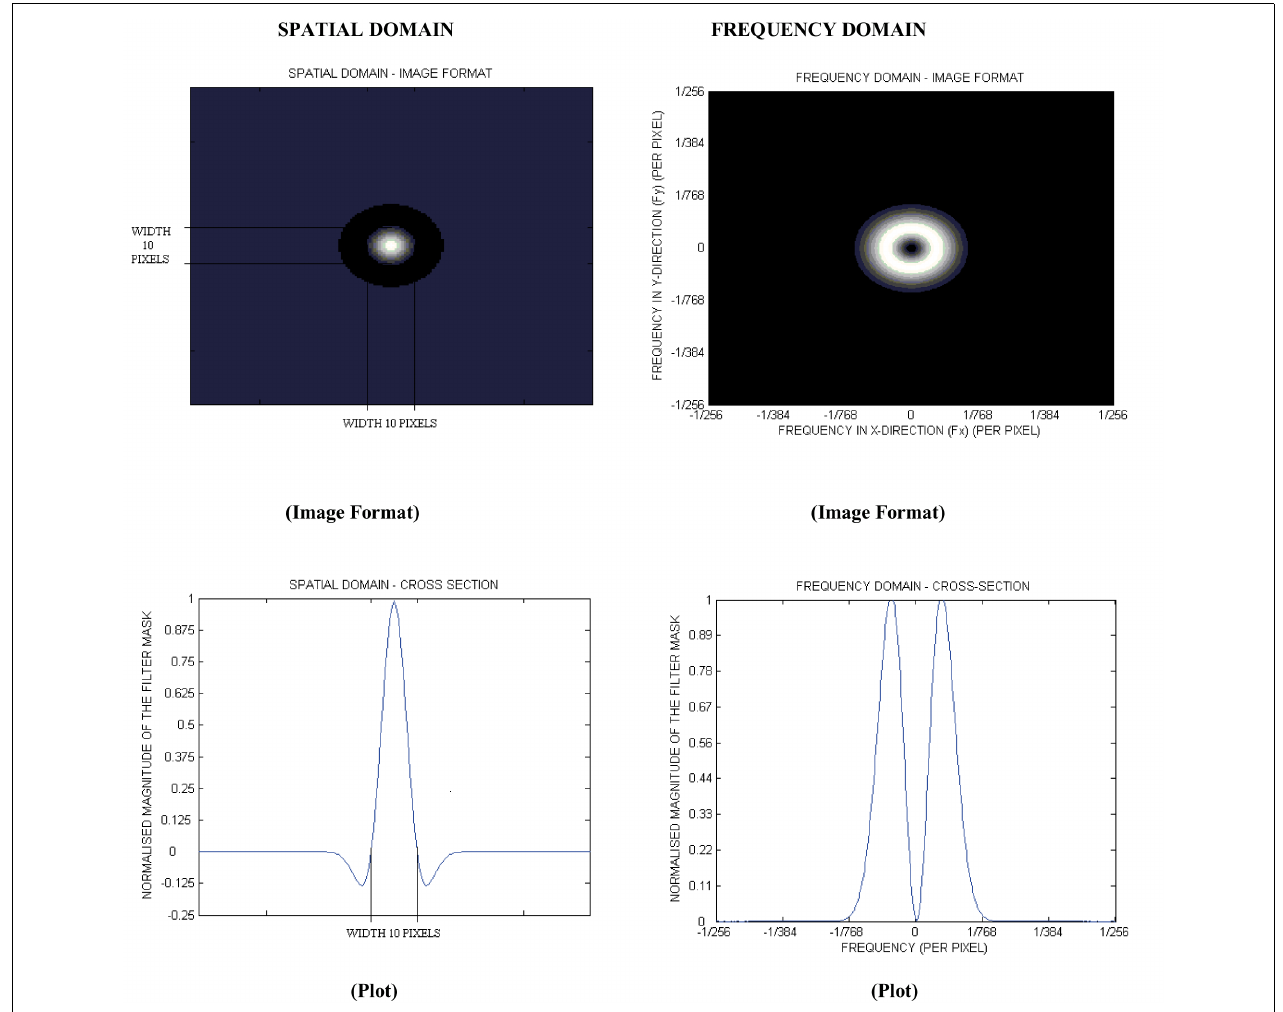
FIGURE 2 |The 2D forms of the log filter in the spatial and frequency domain for a filter ( σ , sigma) value of 2.0.